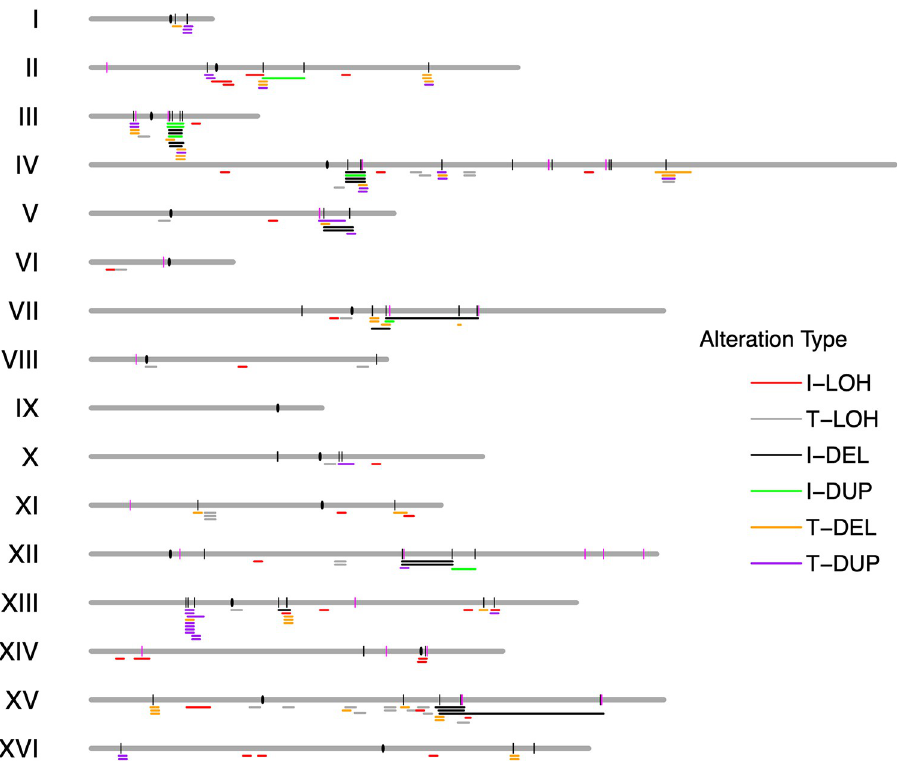
Fig 5. Locations of CRISPR/Cas9-induced genomic alterations relative to the positions of Ty elements. The locations of Ty1 and Ty2 elements are shown as short vertical black or red lines, respectively, and the centromeres are shown as black ovals. Two partial Ty elements with the CRISPR/Cas9 target (one at 803 kb on IV and one at 215 kb on XII) are also shown as black lines. The breakpoints for various types of events are indicated by horizontal lines of different colors. The color code for genomic alterations is: I-LOH (red), T-LOH (gray), I-DEL (black), I-DUP (green), T-DEL (yellow), T-DUP (purple). Most I-LOH and T-LOH events are not associated with Ty elements at their breakpoints, whereas the breakpoints of I-DEL, T-DEL, I-DUP, and T-DUP events are associated with Ty elements.